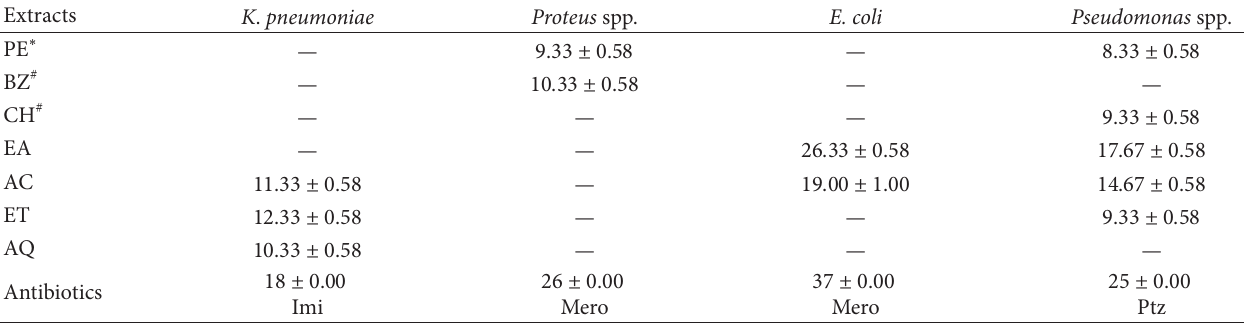
Table 3: Antibacterial efficacy of T. cordifolia stem extracts against bacteria.